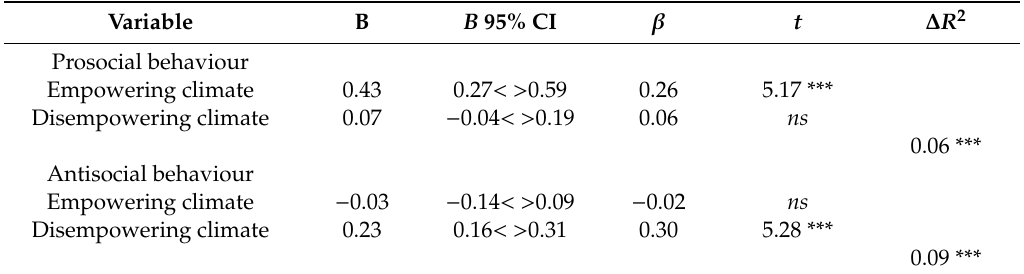
Table 5. The predictive ability of EDMCQ-C in relation to athletes’ moral behaviour in sport. Variable